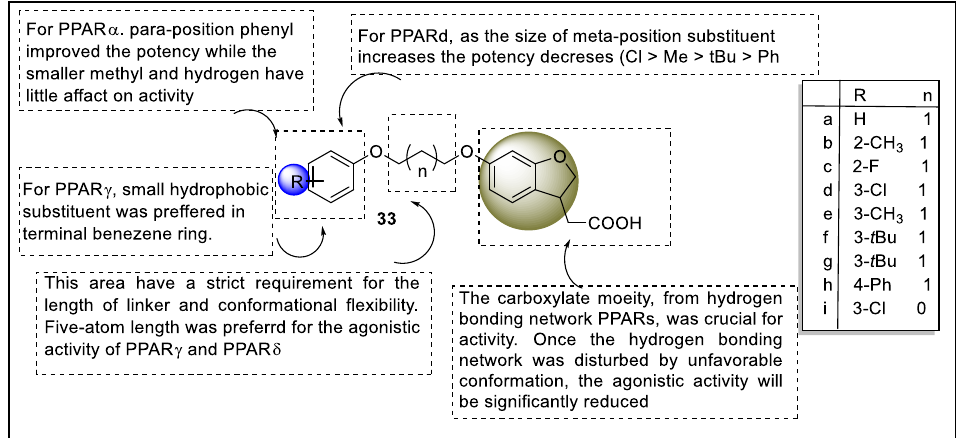
Figure 37. Structural activity relationship of Furan hybrids ( 33 ) as potent PPAR ligands.